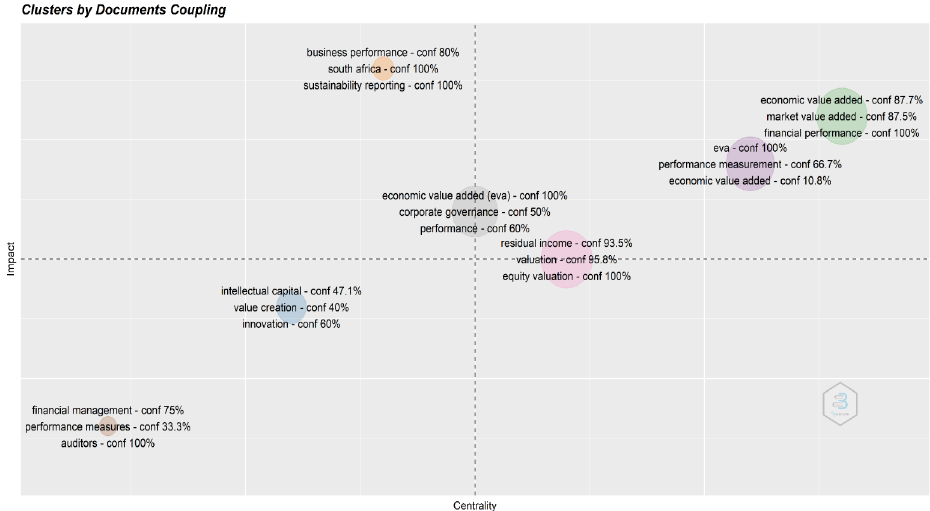
Figure 12. Visual Map of Knowledge Clusters.